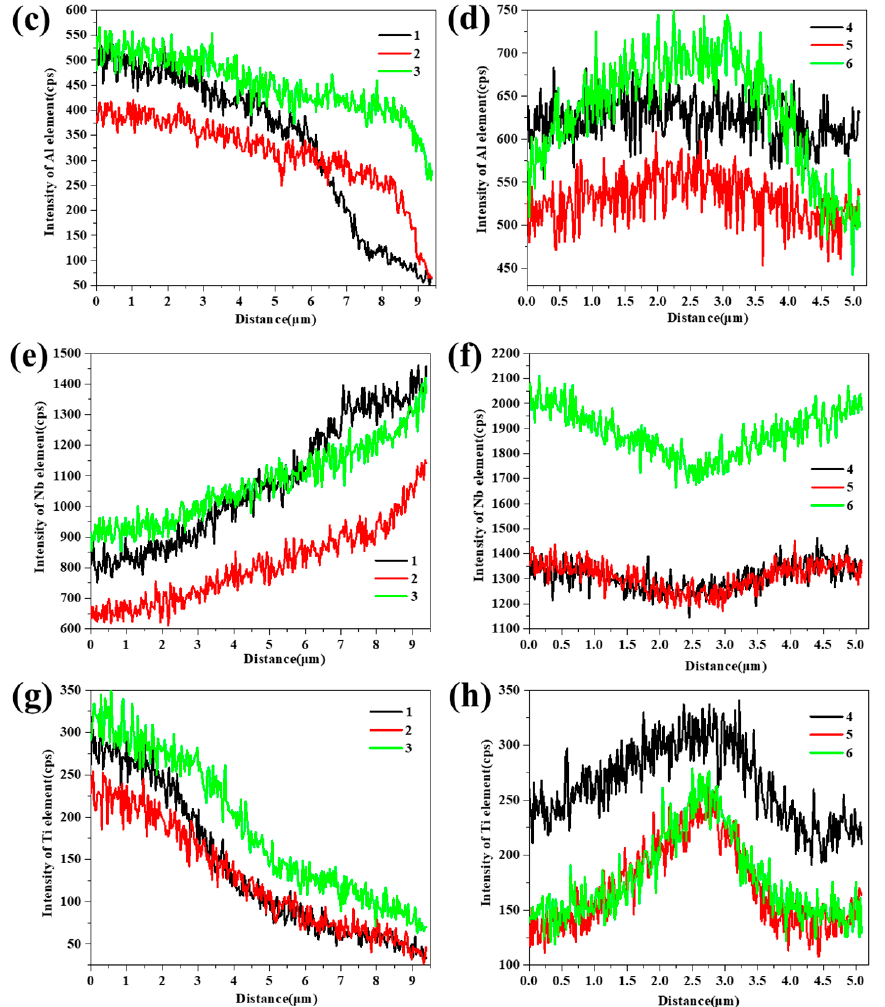
Figure 7. SEM micrograph of a V-groove ( a ) and the relevant SEM-EDS line scanning in it ( b ), the relative content of Al , Nb and Ti along the dot line marked in ( b ) by SEM-EDS line scanning: ( c ) and ( d ) for Al , ( e ) and ( f ) for Nb , ( g ) and ( h ) for Ti .